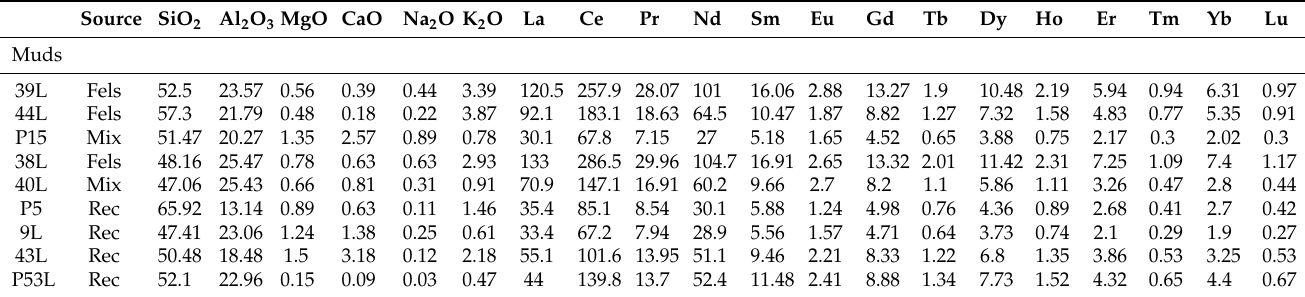
Figure 3. Overall geochemistry of sand and mud deposits, and the composition of sands and muds with distinct source geologies. The range of concentrations between maximum and minimum values is represented in the diagrams. Table 2. Selection of geochemical data obtained with the studied sediments.